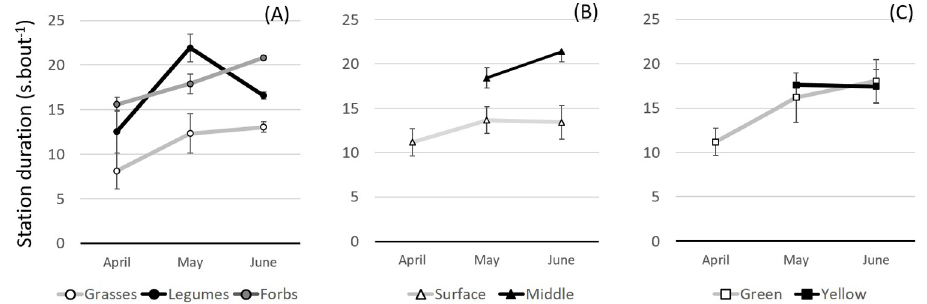
Fig 11. Variation in station duration acording to niche features. (A) Sward functional group; (B) sward vertical strata; (C) plant maturity (mean ± SEM; April n = 20; May n = 25; June n = 10).